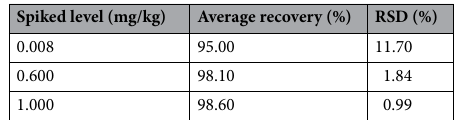
Table 1. The recovery rate and RSD of fluopyram in soil.